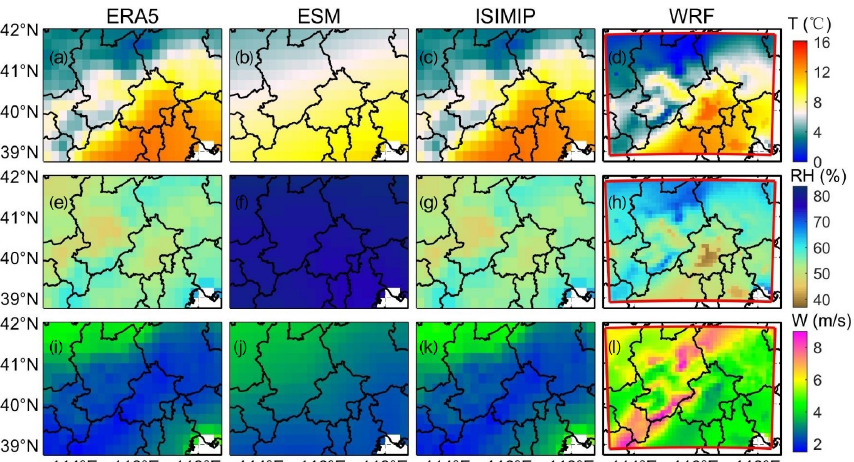
Figure 3. The region containing the high-resolution WRF domain (red boundary in right column maps), with city boundaries marked in black. The spatial distribution of mean 2m temperature (a–d) , relative humidity (e–h) and 10m wind speed (i–l) from ERA5, downscaled ESM ensemble mean before any bias correction, ISIMIP-ESM ensemble mean and the WRF-ESM ensemble mean in the high-resolution domain (Fig. 1) during 1980–1989. The results for the four ESMs are shown separately in Figs. S1–S3 in the Supplement along with the bias-corrected versions.